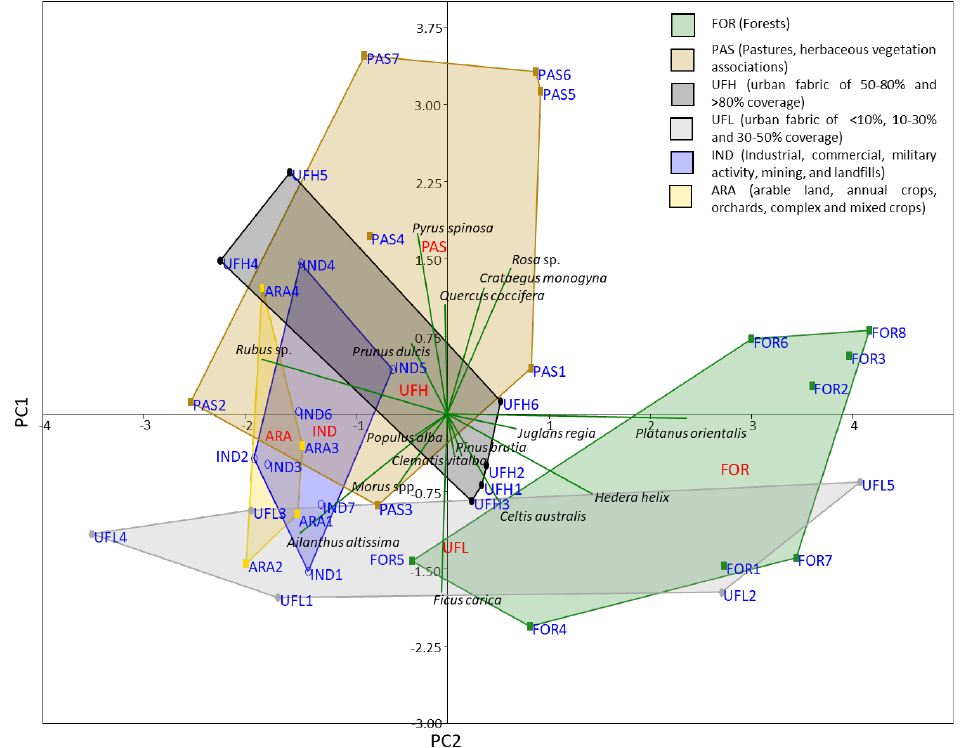
Figure 7. PCA of the dominant tree and shrub taxa distribution along the riparian zone of Dendropotamos in relation to different land uses (RMP coverage data). Alien/introduced taxa (e.g., A. altissima , F. carica , and Morus spp.) characterize human-induced land-use classes, elements of grazed shrublands (e.g., Q. coccifera , P. spinosa , and Rosa sp.) separate the ‘pasture’ segment of Dendropotamos, while high presence of riparian taxa such as P. orientalis and H. helix characterize most of its forested part.